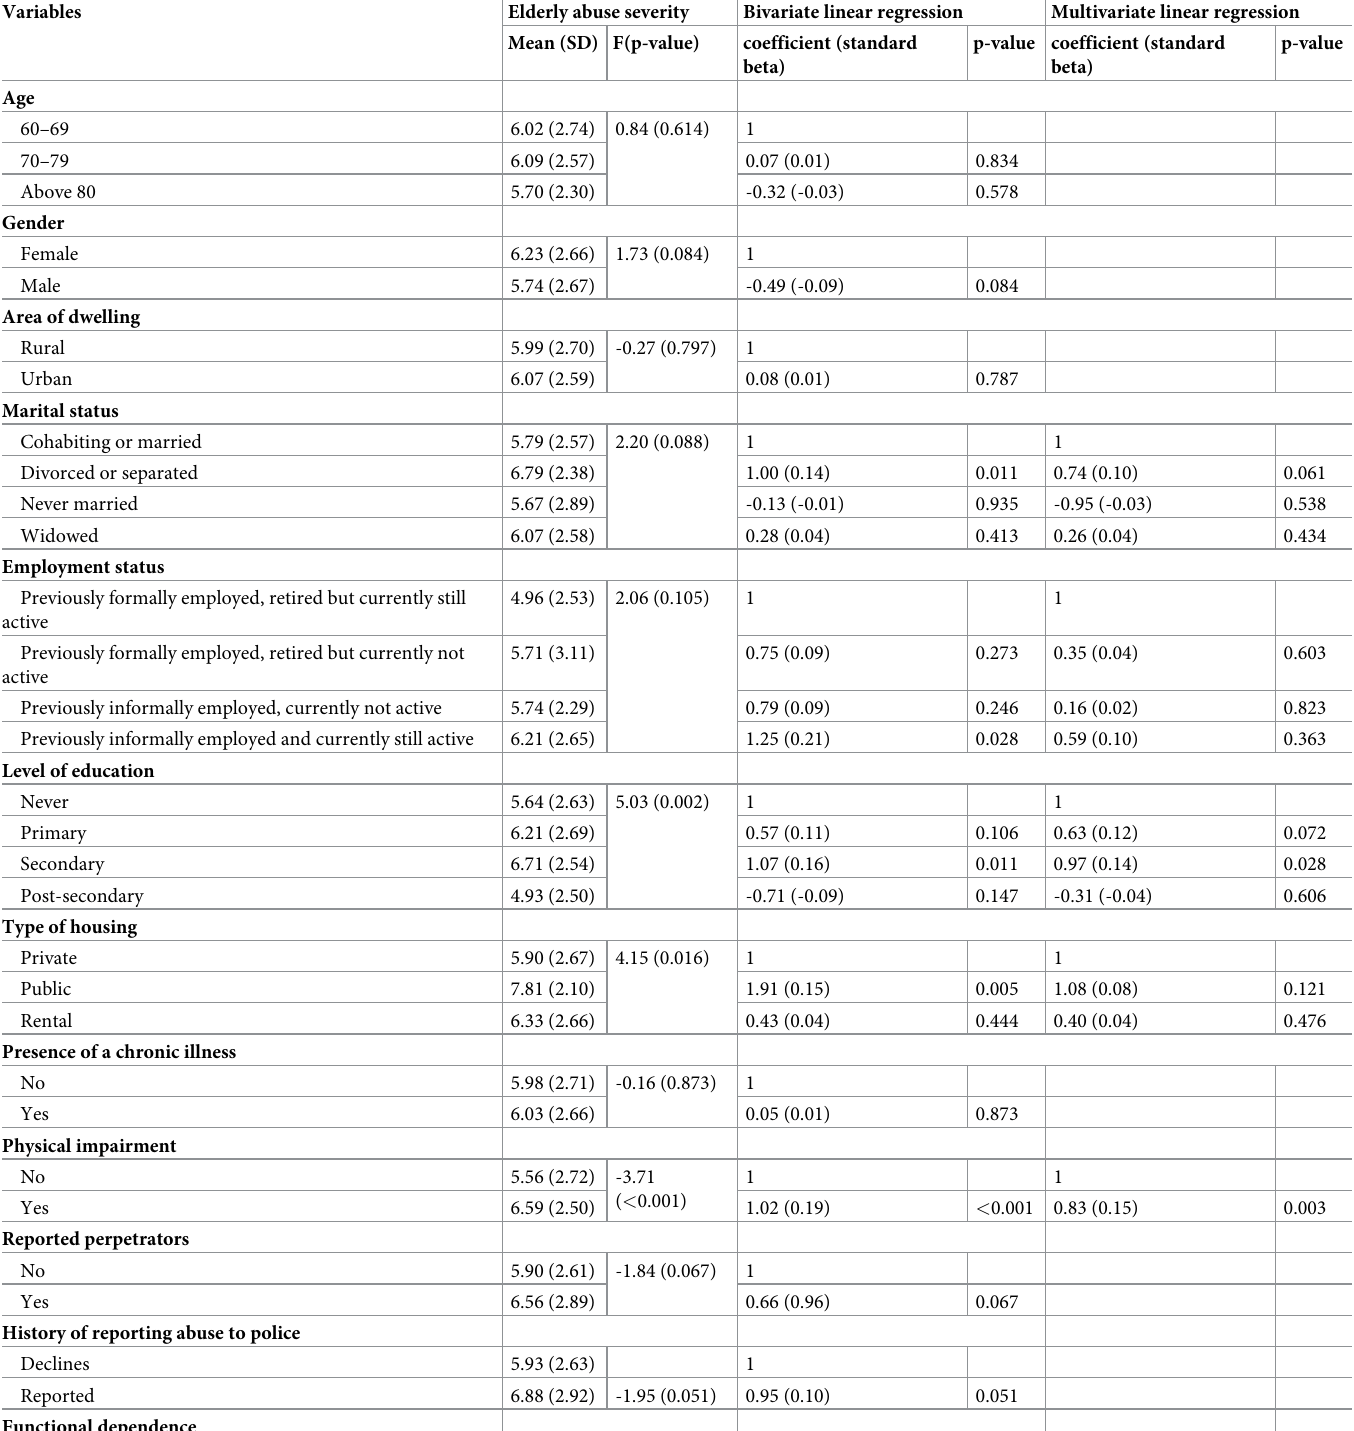
Table 2. Associations between elder abuse severity and the studied